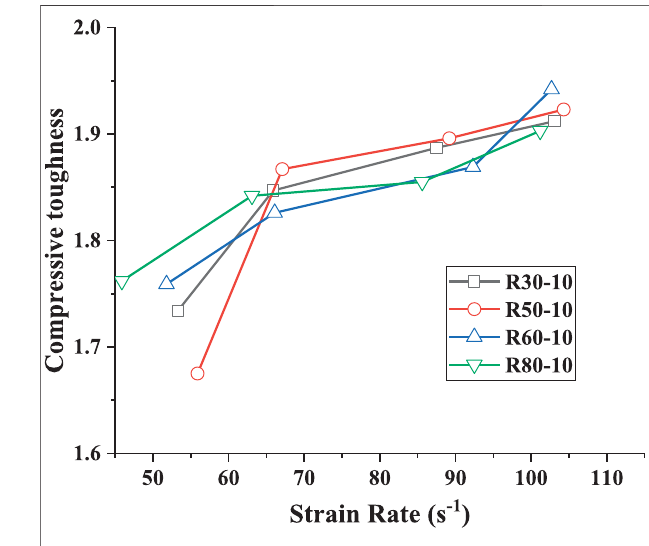
FIGURE 18 | The relationship between critical strain and strain rate of rubber mortar with different sizes of crumb rubber.